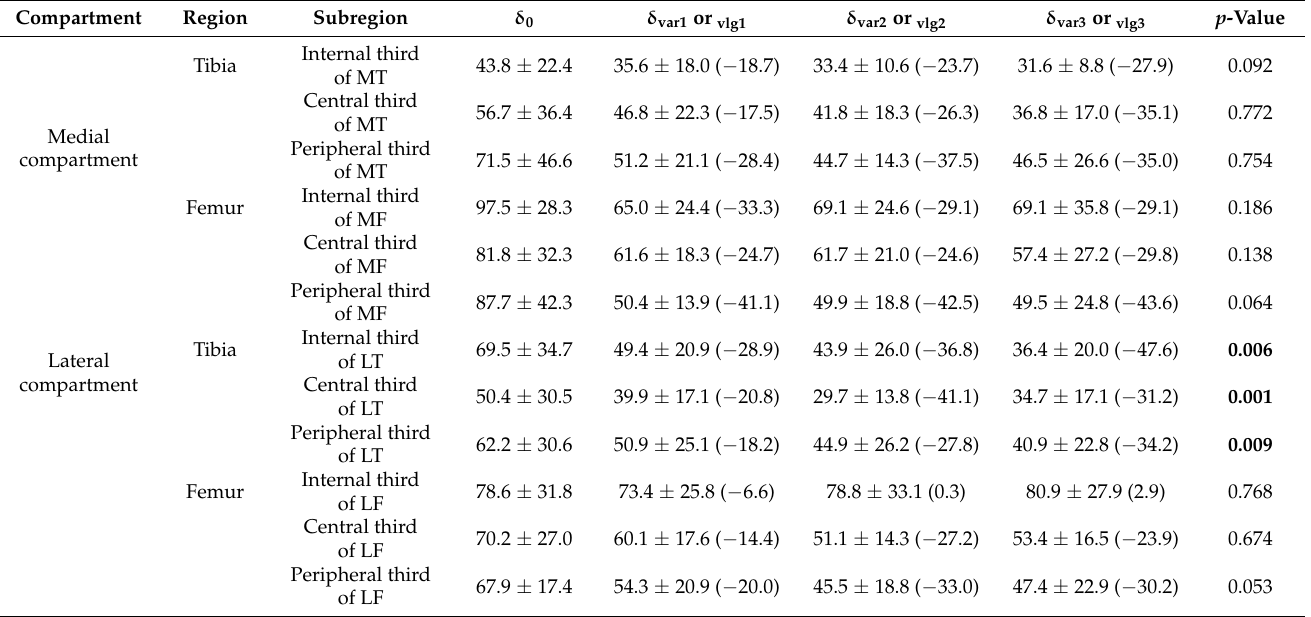
Table A2. Mean absolute T1 ρ relaxation times of femoral and tibial cartilage subregions in response to loading. Mean ± standard deviation (ms) (mean percentage change versus δ 0 (%)). Statistical analysis was performed using Friedman’s test and statistically significant findings are highlighted in bold type . Please refer to Table 2 for additional details on table